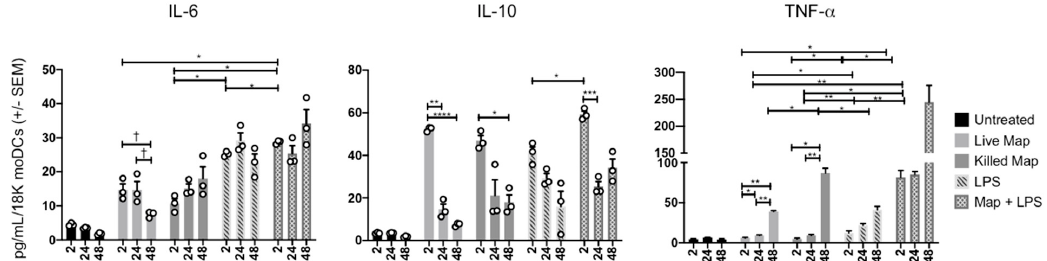
Figure 3. MAP-infected moDCs display a downregulated pro-inflammatory phenotype. MoDCs (1.8 × 10 4 cells) were untreated or infected / treated with the same number of opsonized MAP, killed MAP (KMAP), or LPS alone for T = 0 (2 h), T = 24 h, and T = 48 h. Supernatants were collected and ELISA for IL-6, IL-10, and TNF α was performed. * p < 0.05; ** p < 0.01; *** p < 0.001; p < 0.0001 **** as calculated using two-way ANOVA with multiple comparisons; † p < 0.05, t -test. Shown is the average ± SEM of n = 3–4 DC blood donors analyzed in triplicate.